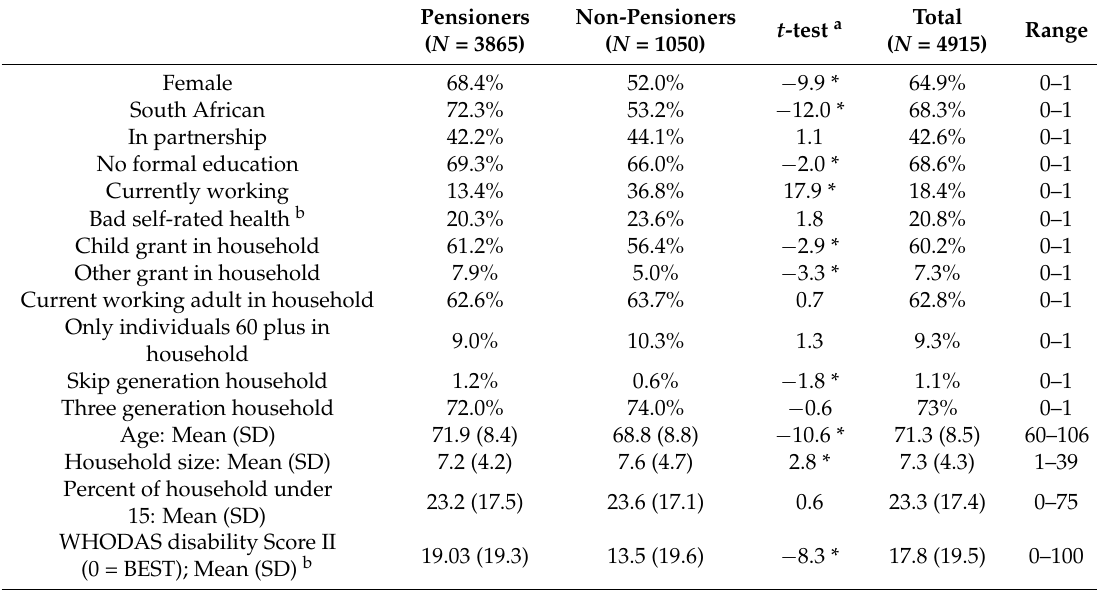
Table 2. Description of adults 60+ by pension receipt, Agincourt HDSS and WHO-SAGE 2010.